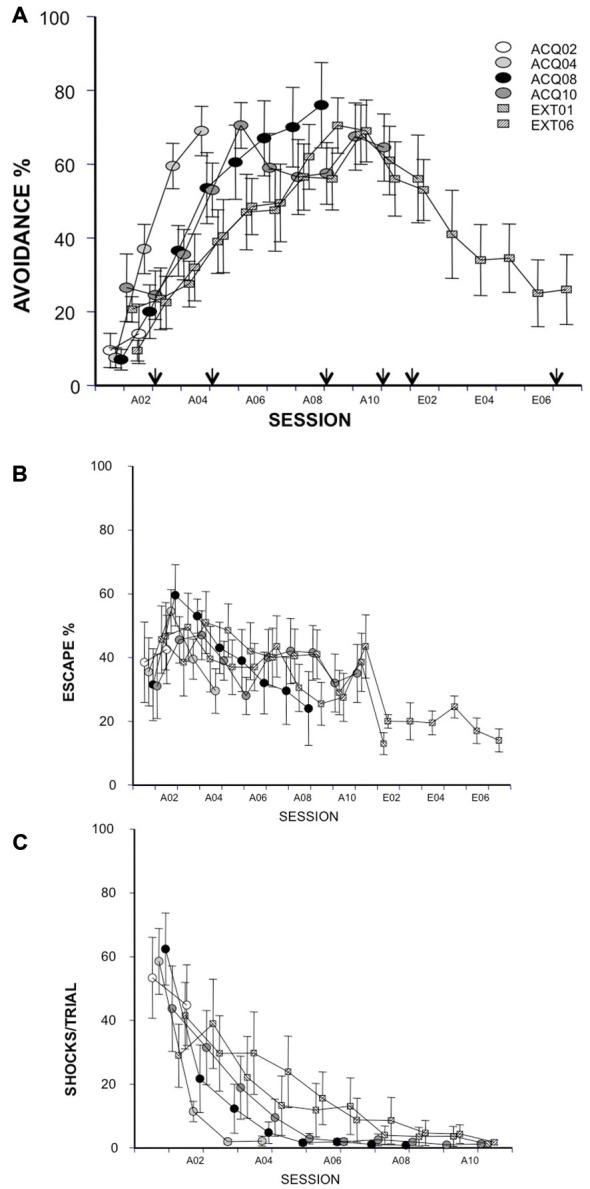
Avoidance response, escape response and shock number received in acquisition (10 sessions) and extinction (6 sessions) were expressed as avoidance (A, arrows indicate time points of c-Fos-ir evaluation) and escape (B) ratios and the average numbers of received shocks in each session during acquisition (C). Each data point represents group mean ± S.E.M. (n = 8–10/group; data of 2 subjects from group EXT01 and 1 subject from group EXT06 were lost from session A01 due to a power failure during training).